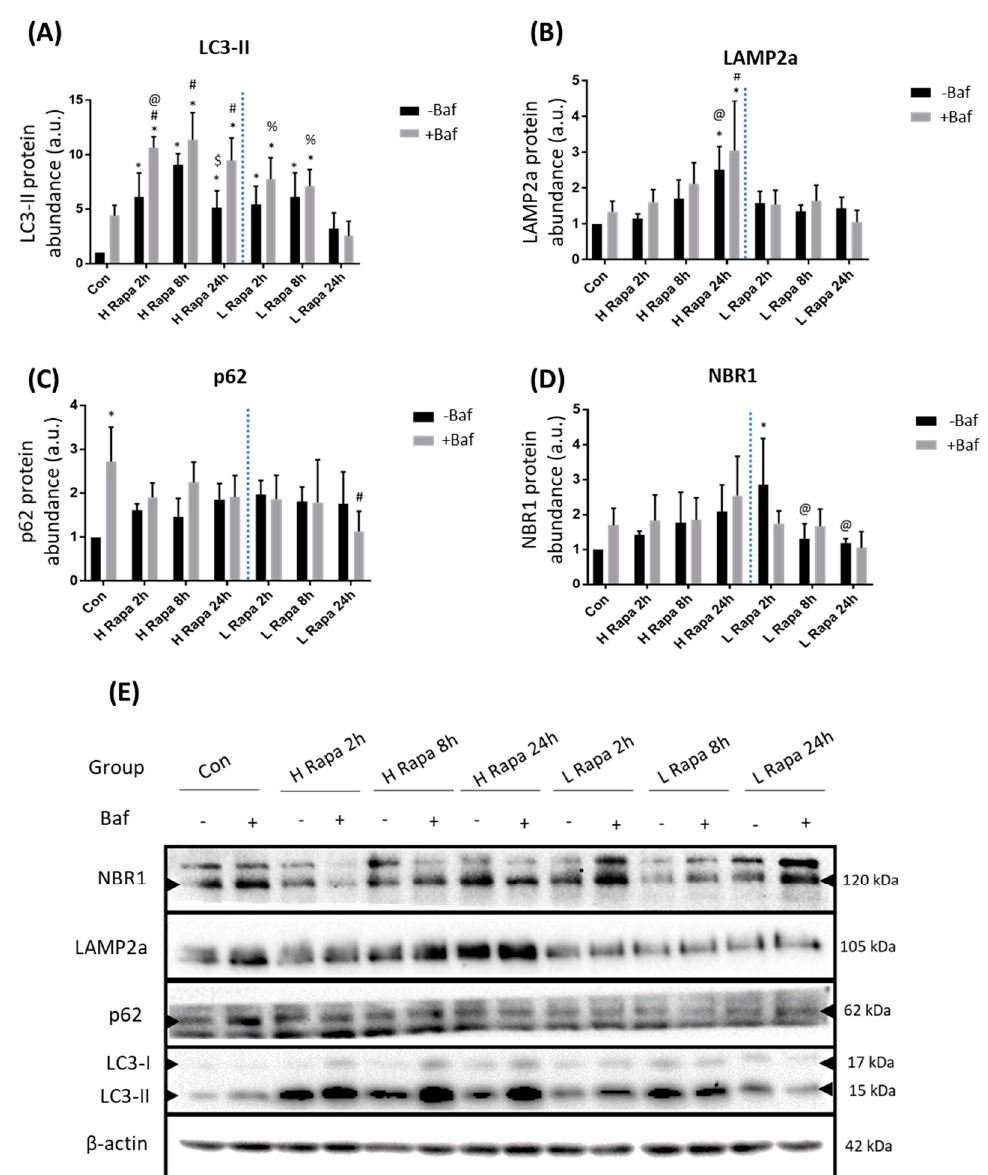
Figure 1. Western blot analysis following 1 µM (H Rapa) and 10 nM (L Rapa) rapamycin incubation over 24 h in the presence (+Baf) and absence (-Baf) of bafilomycin. N = 3. ( A ) LC3-II protein levels. * p < 0.05 vs. Con, # p < 0.05 vs. Con +Baf, @ p < 0.05 vs. 2h –Baf H Rapa, $ p < 0.05 vs. 8h –Baf H Rapa, % p < 0.05 vs. 24h +Baf L Rapa. ( B ) LAMP2a protein levels.